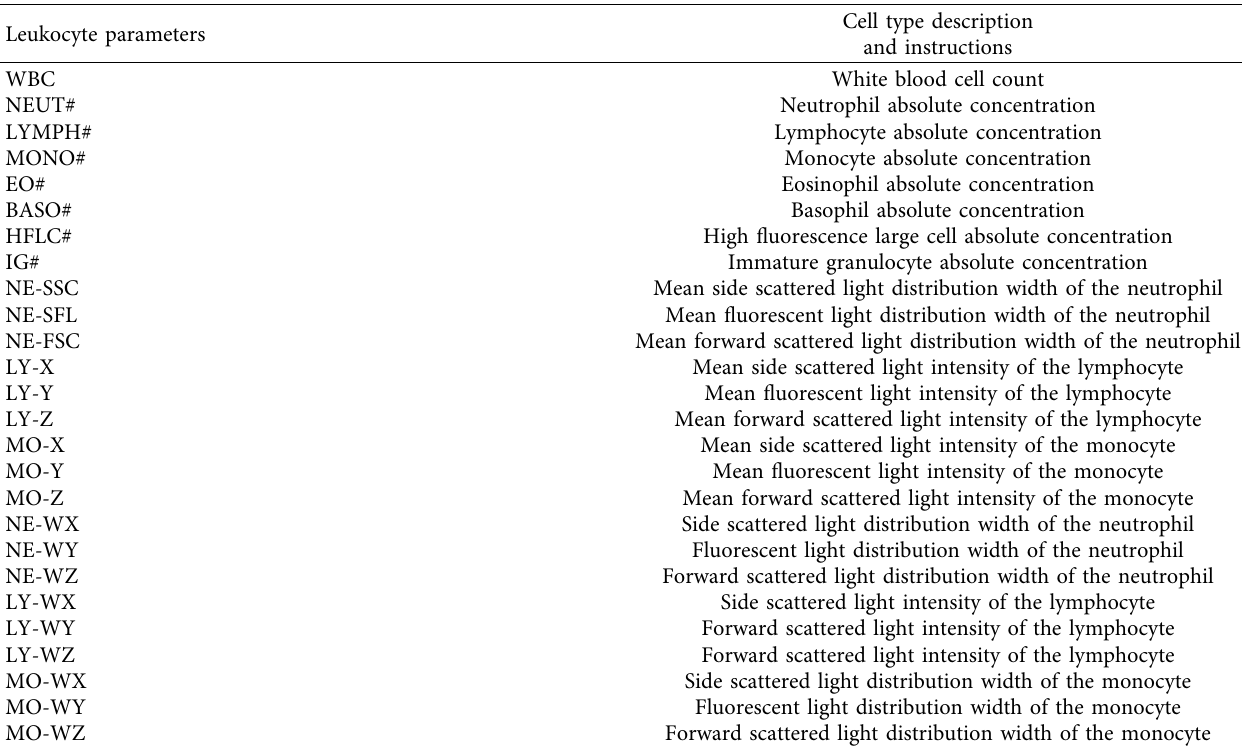
Table 1: Brief description of leukocyte